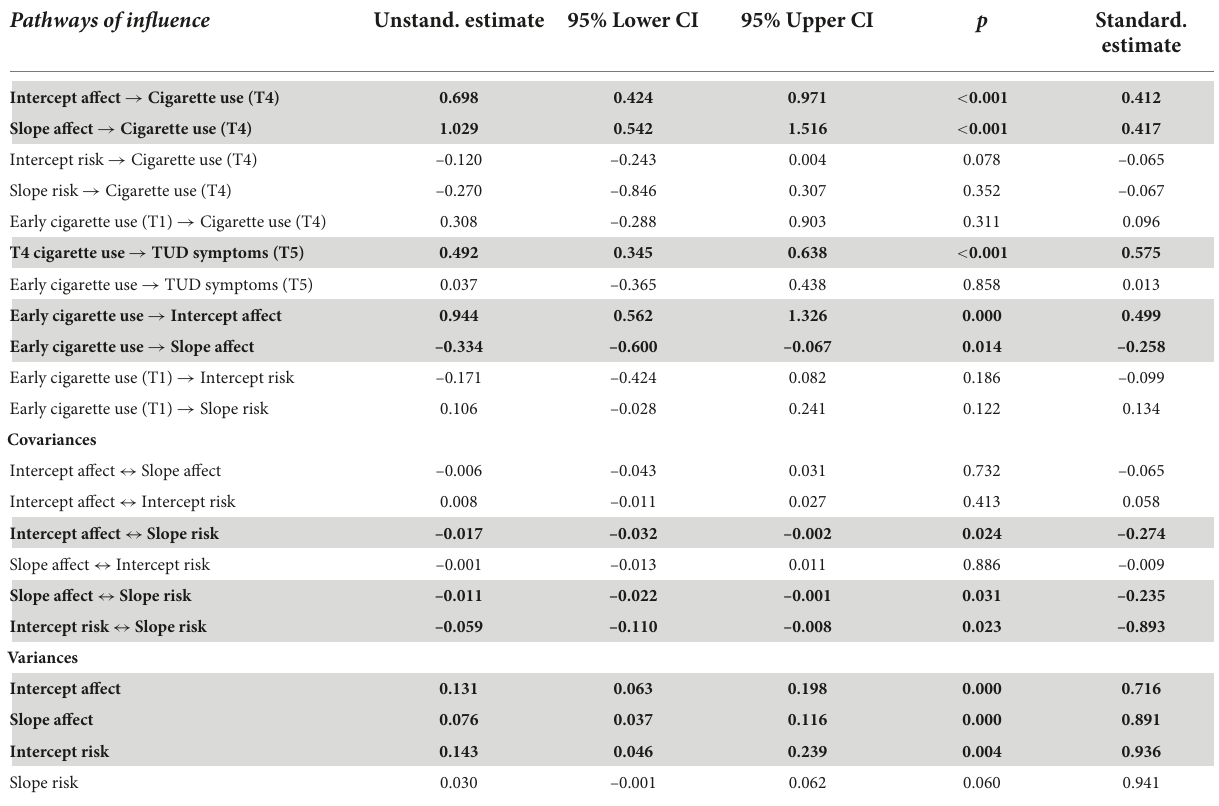
TABLE 3 Parameter estimates from full